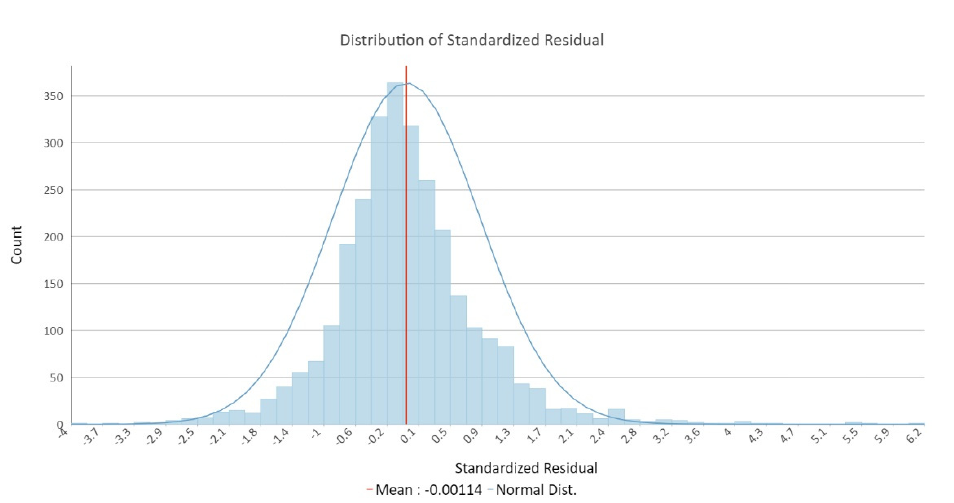
Figure 10. Histogram of the GWR standardized residuals.